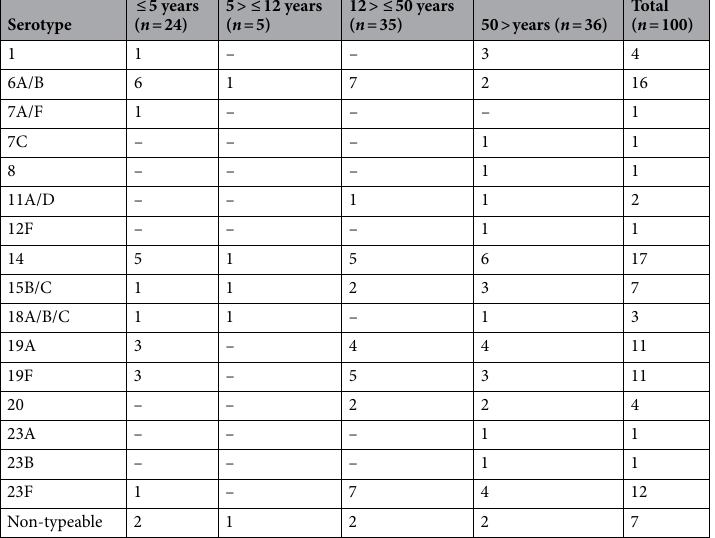
Table 1. Serotype distribution of pneumococcal isolates in relation to patient age group.